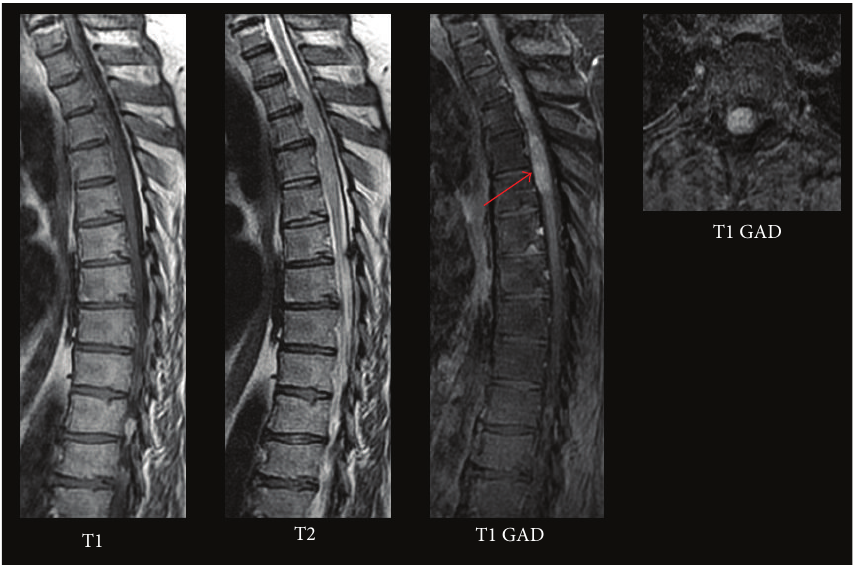
Figure 1: Preoperative thoracic MRI shows three sagittal sequences (T1, T2, and T1 with gadolinium) on the left and an axial (T1 with gadolinium) on the right demonstrating an intramedullary mass between T2 and T5 (arrow). spinal cord with diffuse enhancement and cord expansion (Figure 1). Imaging of the remaining neural axis was negative.